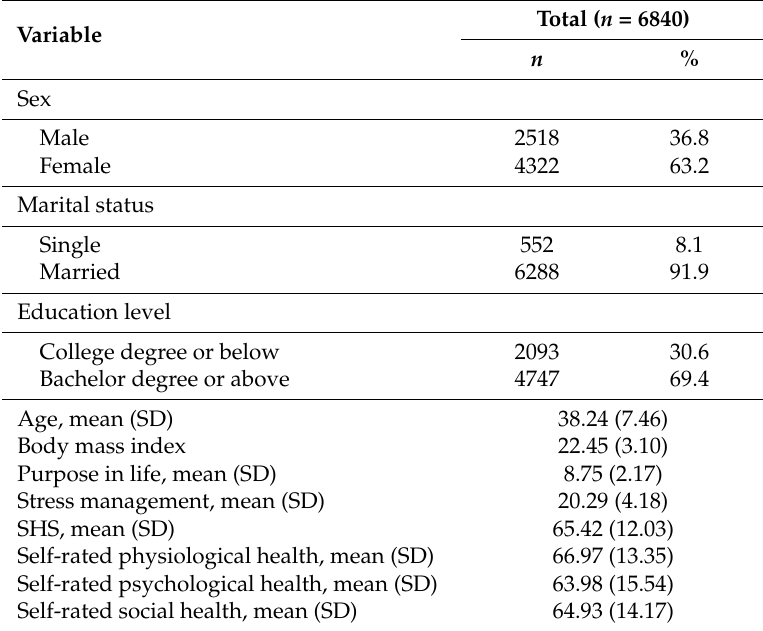
Table 1. Sample characteristics ( n = 6840).